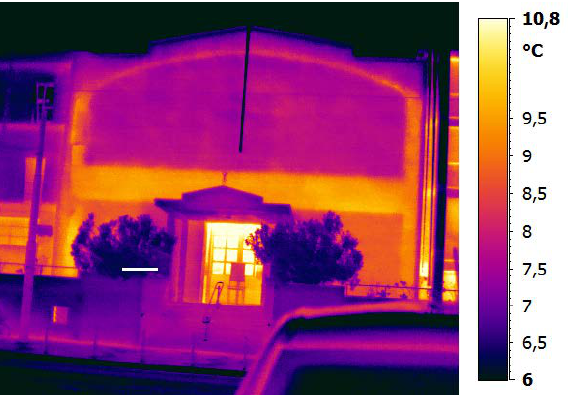
Figure 2 – Thermogram of the southern façade of Case Study 1 during the solar irradiation, air temperature 12°C; emissivity 0.92. The black part at the bottom is due to the trees and entrance porch that were not an objective of the present investigation; therefore, the optimized range of temperatures excluded that colder part of the image.